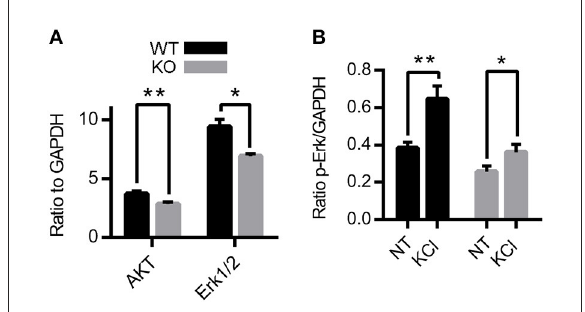
FIGURE2 Protein level and activity-dependent phosphorylation of AKT and Erk1/2 are reduced in ZnT3KO hippocampus. (A) Basal levels of AKT and Erk1/2 proteins are reduced in ZnT3KO. (B) Incubation with 20mM KCl results in a greater increase in p-Erk1/2 in WT than in ZnT3KO hippocampus. WT, wild type; KO, ZnT3KO; AKT, Erk1/2, n = 6; p-Erk1/2, WT, n = 4, KO, n = 5; NT, no treatment (vehicle); KCl, 10-min incubation in 20mM KCl; * p < 0.05, ** p < 0.01; values expressed as normalized densitometry relative to GAPDH. Data were analyzed by two-tailed unpaired t -test. Error bars indicate the mean ± SEM.